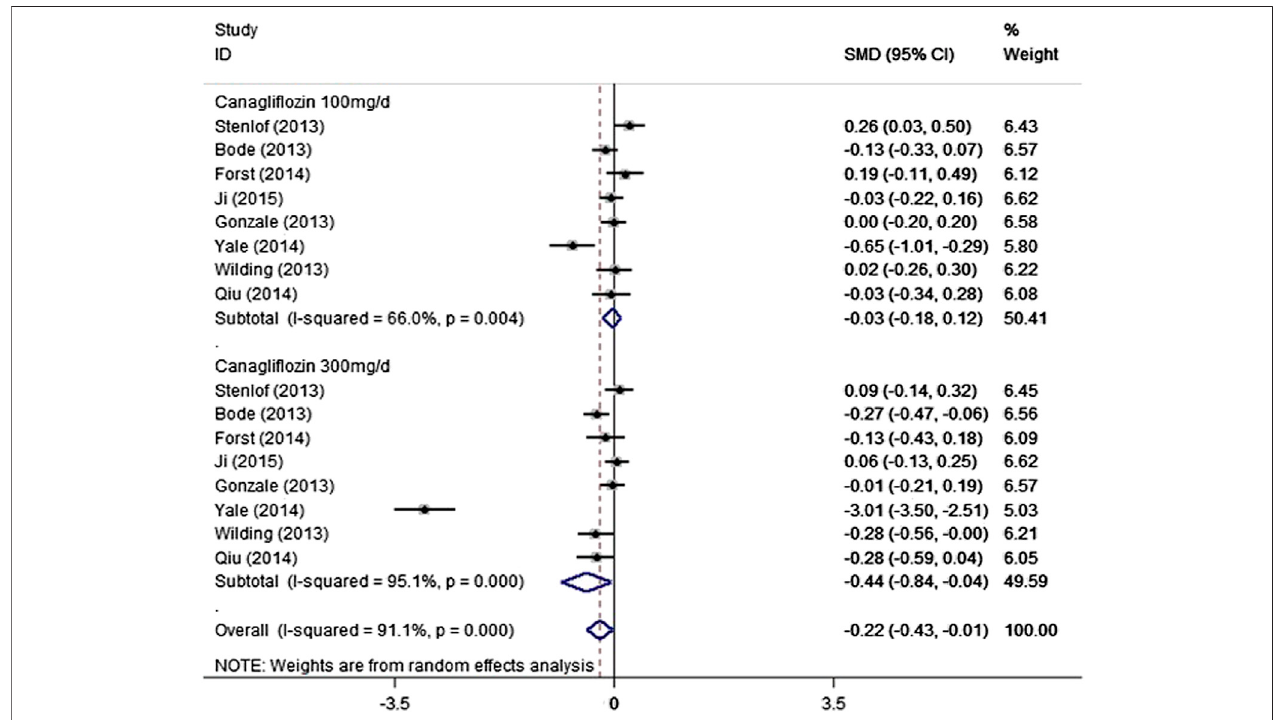
FIGURE 5 | Forest plot detailing subgroup analysis of the effect of canagli fl ozin on the eGFR of the T2DM participants based on dosage.